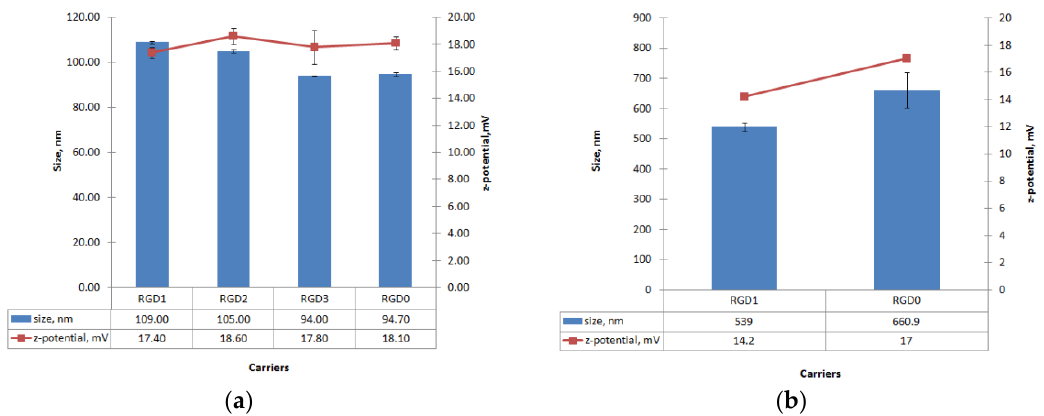
Figure 5. Size and zeta-potential of carrier/DNA ( a ) and carrier/siRNA ( b ) complexes at N/P ratio 8/1. The data are shown as the mean ± SD